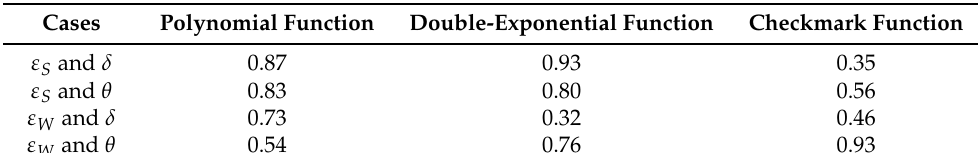
Table 9. The degree of fit ( R 2 ).